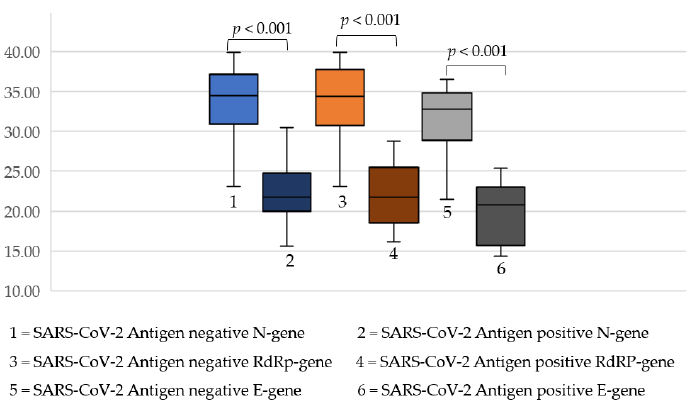
Figure A1. Distribution of different Ct values from people tested either RAT+ or RAT − in the pediatric group.